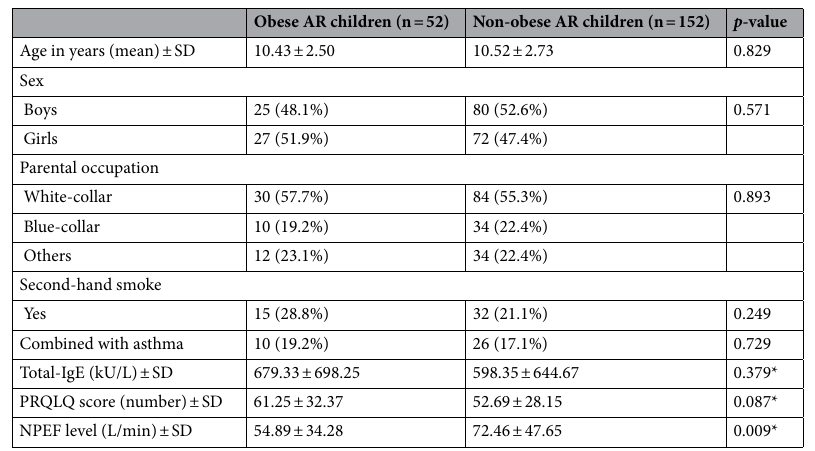
Table 1. Demographic data, total-IgE, PRQLQ score and PEFR rates. * p -value: adjust by age, sex, parental occupation, second-hand smoke, combined with asthma. SD: standard deviation.